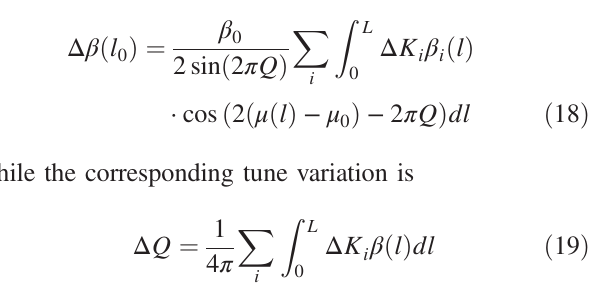
FIG. 7. ρ ð M ð Δ Q for image charge based tune shift for three y ÞÞ different initial vertical tunes.